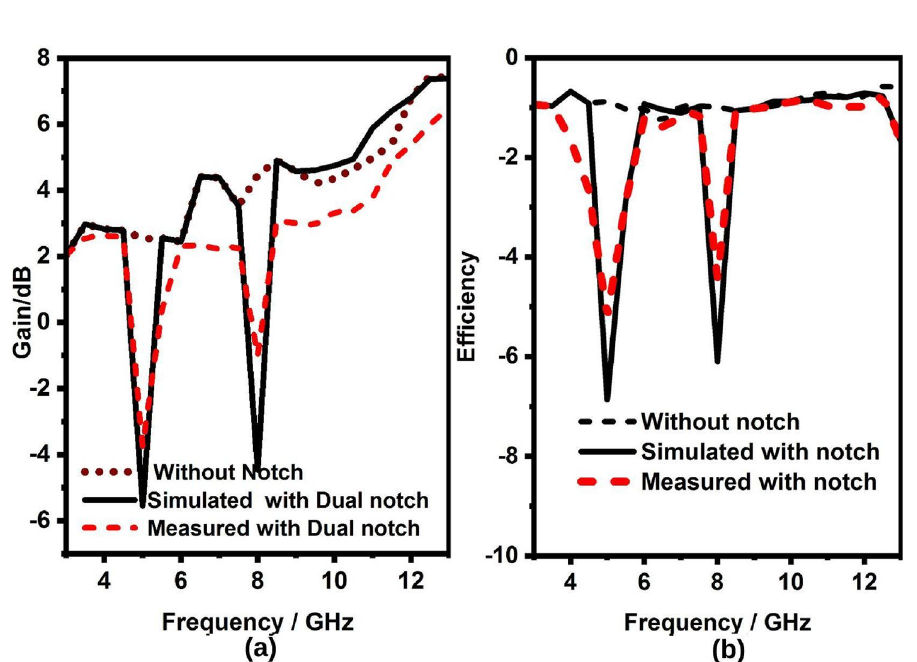
2 band notch UWB MIMO antenna. ×